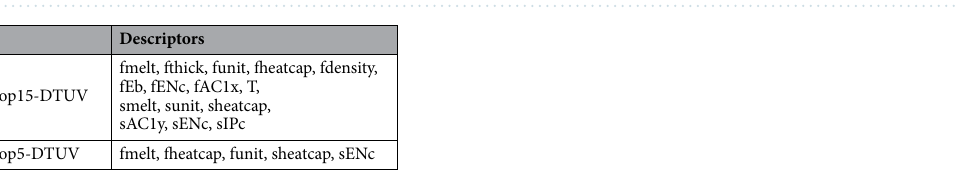
Table 2. Common descriptors selected by decision tree and univariate